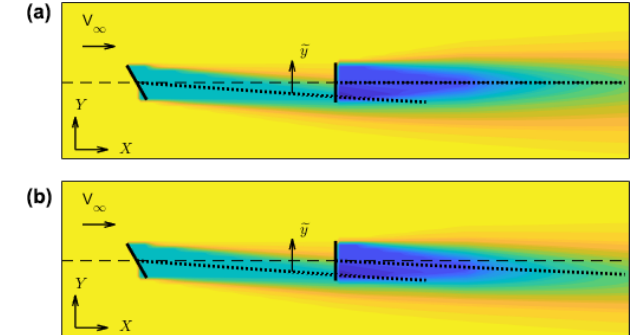
Figure 1. Effect of secondary steering on the trajectory of a down- stream turbine. (a) Baseline wake model; (b) baseline model aug- mented with the empirical correction term of Eq.